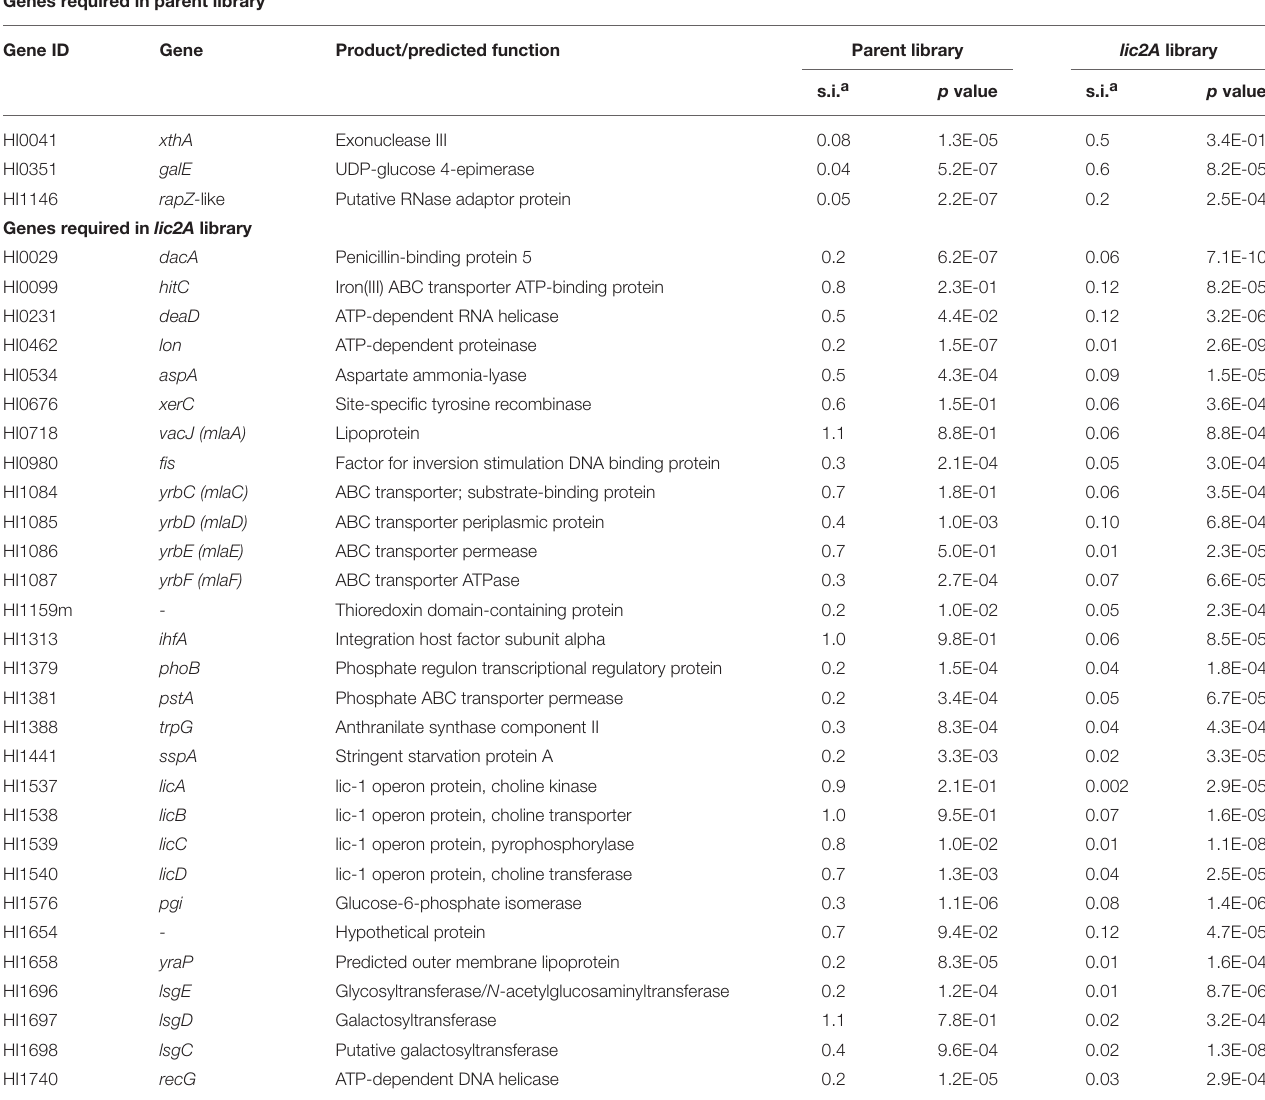
TABLE 2 | Genes required in H. influenzae parent or lic2A library. Genes required in parent